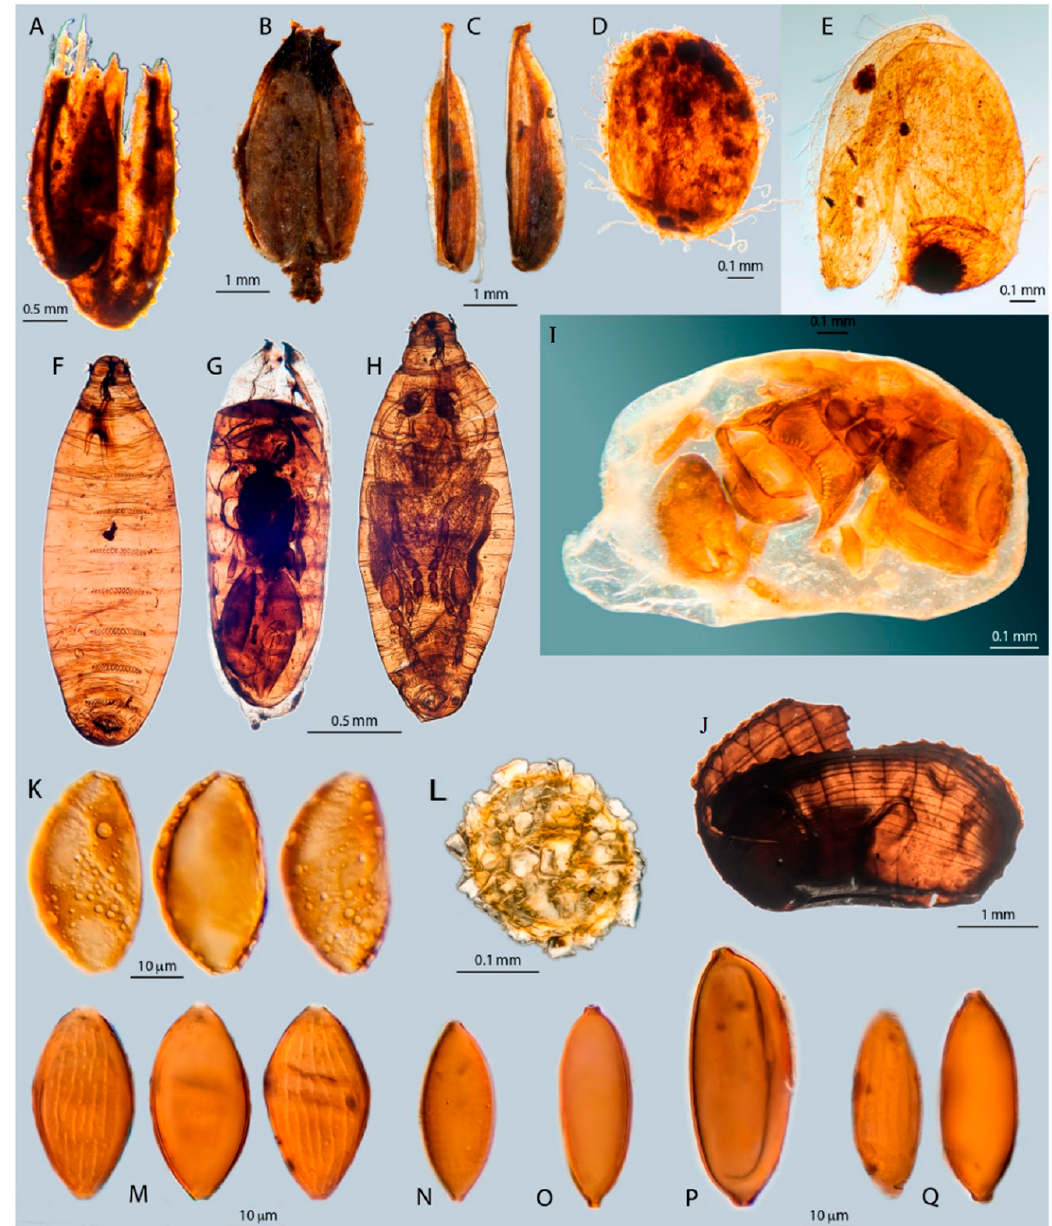
Figure 4. ( A ) Anthriscus caucalis , seed; ( B ) and ( C ) Triglochin maritima , fruit and seeds; ( D ) and ( E ) Salicornia europaea , seeds; ( F – H ) Sphaeroceridae, puparia, ( H ) with adult inside, ( G ) with a parasitoid Hymenopteron inside; ( I ) parasitoid wasp Anteris spec. inside an arthropod egg; ( J ) Ectobius lapponicus / sylvestris , ootheca; ( K ) HdV-598 spores; ( L ) HdV-597 macrofossil; ( M – Q ) ascospores of Neurospora (HdV-55B / C) with, and without longitudinal